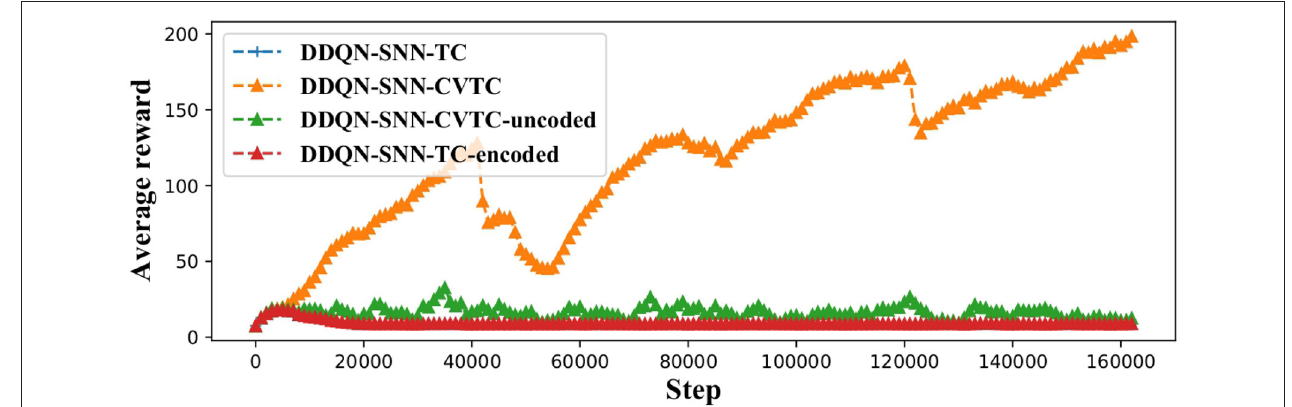
FIGURE 4 | Training curves on CartPole task.